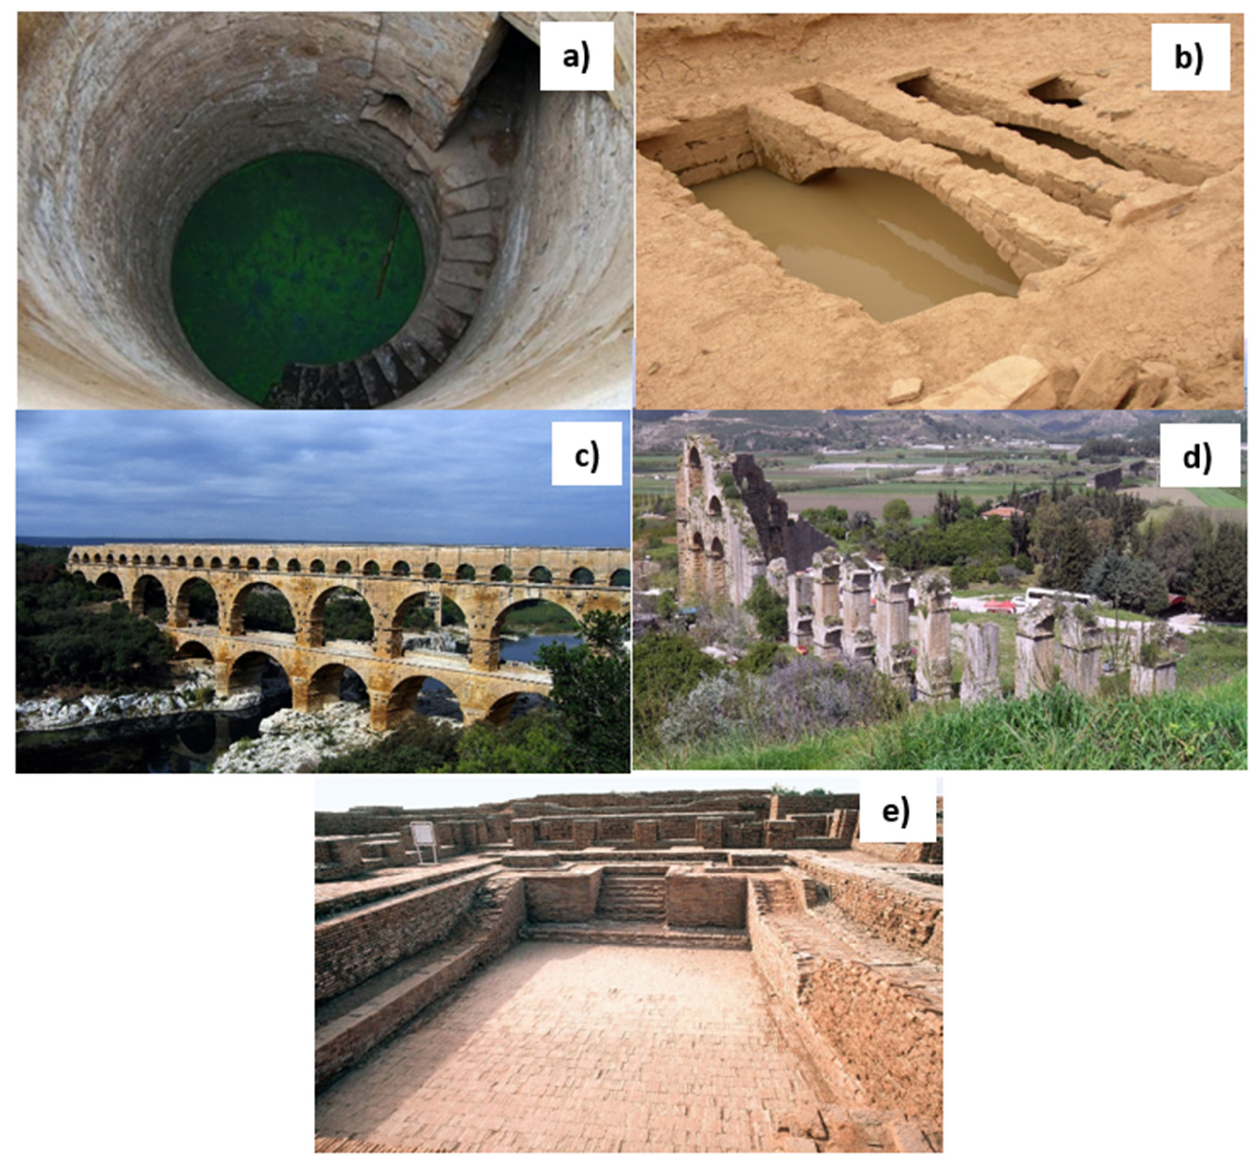
Figure 2. ( a ) Sinking shafts, Egypt (Claudio Caridi/Adobe stock); ( b ) cisterns, Jordan https://brewminate.com/controlling-the-municipal-water-supply-in-the-ancient-graeco-roman-world/, ac- cessed on 20 July 2022; ( c ) aqueducts, Rome https://wallpapic.com/bridge-pont-du-gard-arch-vers/0xfGzO, accessed on 20 July 2022; ( d ) inverted siphons, Ancient Rome https://followingha- drian.com/2013/04/17/exploring-aspendos-images-from-a-wealthy-city-of-pamphylia/, accessed on 20 July 2022; and ( e ) great bath, Indus Valley Civilization https://delphipages.live/id/geografi-